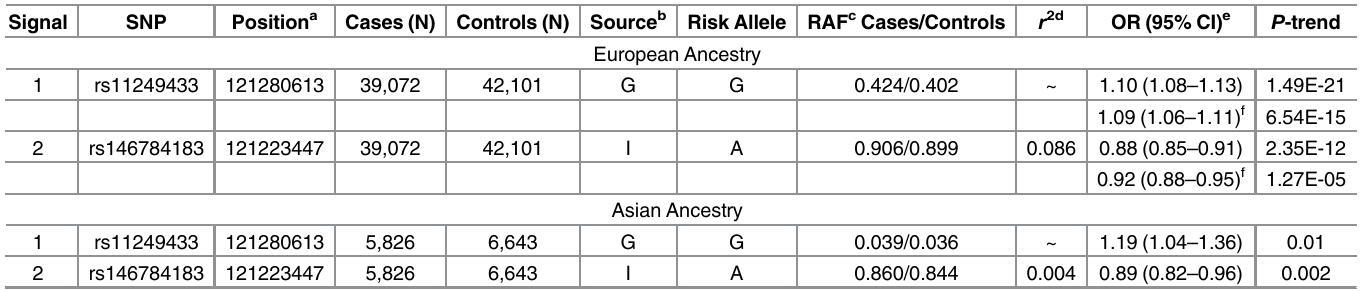
Table 1. Two independent association signals at the 1p11.2 locus: Association results for breast cancer risk among women in BCAC, by ancestry. Signal